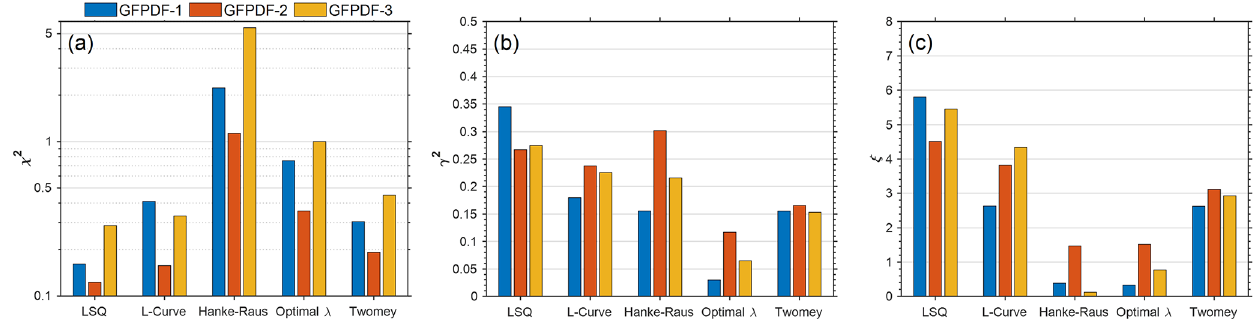
Figure 5. The reconstruction residual ( χ 2 ) (a) , the GF-PDF error ( γ 2 ) (b) , and the smoothness ( ξ ) (c) of the GF-PDF inverted using LSQ, first-order Tikhonov regularization with the regularization parameter derived from three different approaches (L-curve, Hanke–Raus rule, and optimized λ ), and Twomey’s method. The colors correspond to the pre-defined GF-PDFs with one mode (blue), two modes (orange), and three modes (yellow).